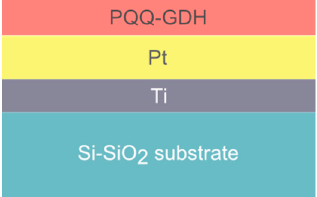
Figure 2. Adrenaline thin-film biosensor arrangement with enzyme